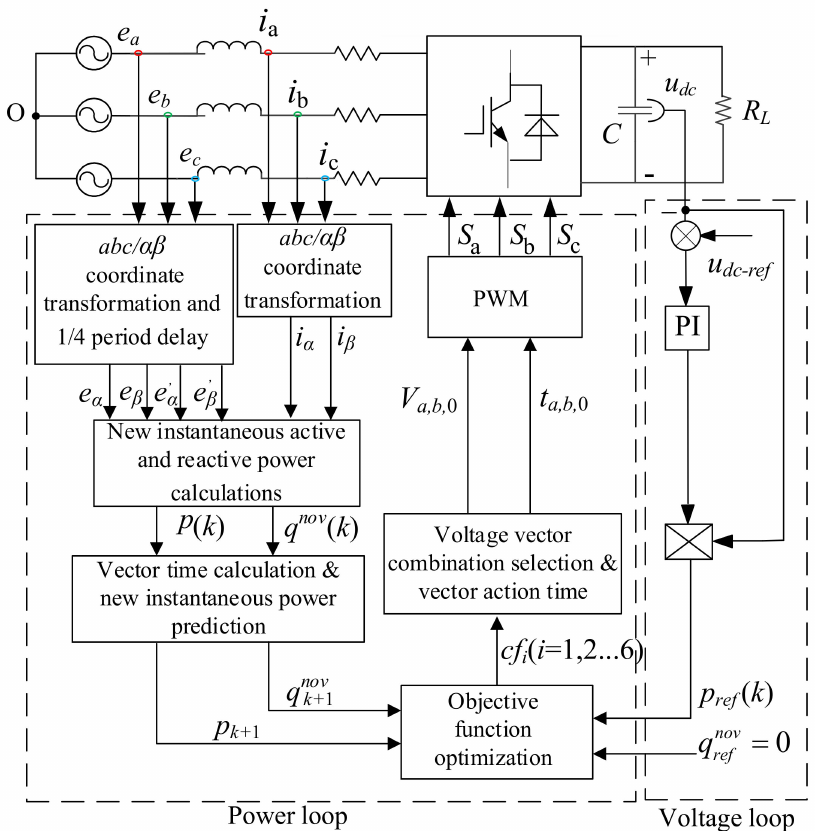
Figure 3. Control diagram of novel FCS-MPDPC.